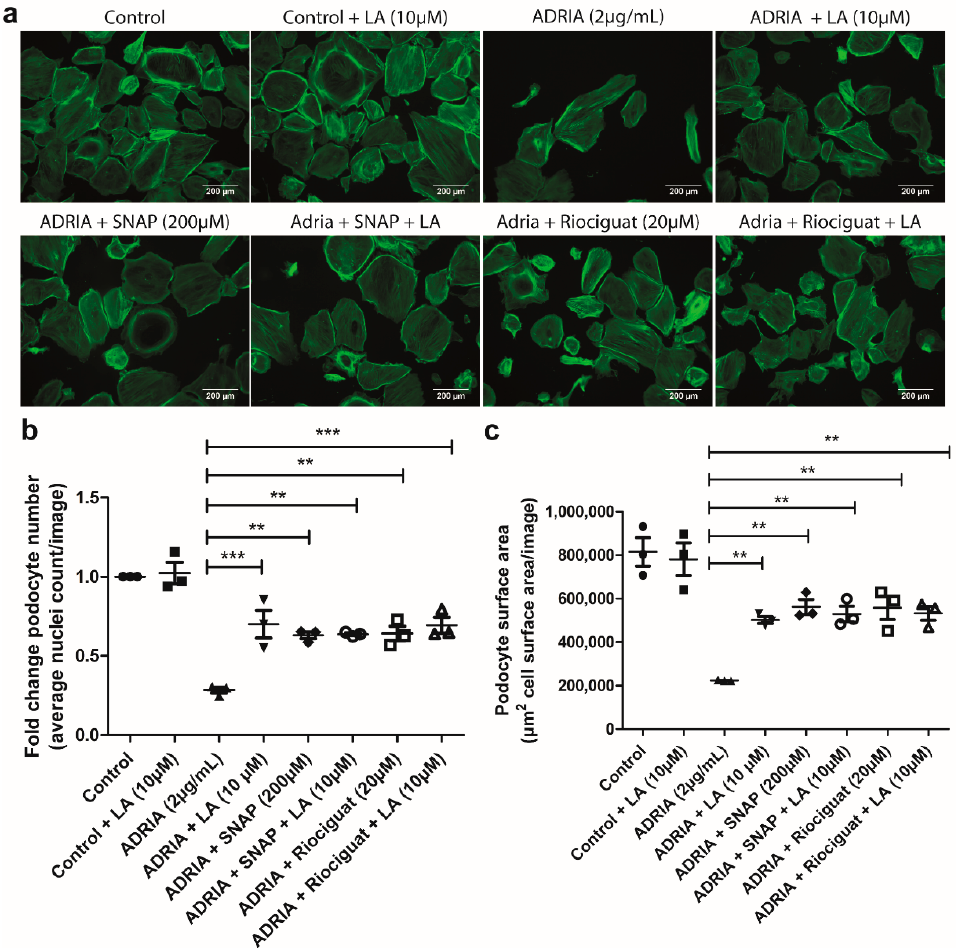
Figure 7. Riociguat and SNAP prevent Adriamycin-induced podocyte injury via inhibition of TRPC6. hPOD were treated for 24 h with 2 µg/mL Adriamycin to induce podocyte injury. Podocytes were simultaneously treated with 10 µM Larixyl Acetate (LA) with or without 20 µM Riociguat or 200 µM SNAP. Podocytes were subsequently stained with Phalloidin-FITC and Hoechst 33342. ( a ) Representative pictures are shown for all conditions. ( b ) Quantitative analyses in FIJI for average cell count for LA without or with Riociguat or SNAP and ( c ) total cell surface area per image for LA without or with Riociguat or SNAP. ** p < 0.01 *** p <